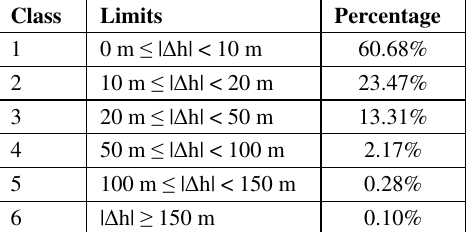
Table 3. Classes of elevation differences between Switzerland and Lombardy and their percentages